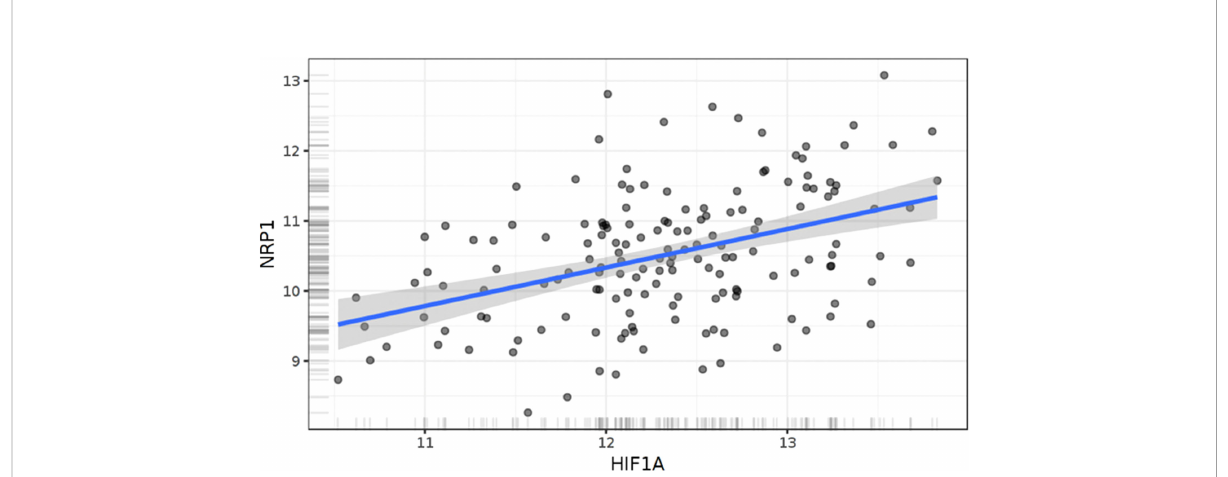
FIGURE 3 Correlation of Hif1 a and Nrp1 expression in human glioblastoma. Linear regression of NRP1 expression against HIF1 a . The results shown here are based upon data generated by the TCGA Research Network: https://www.cancer.gov/tcga." N=158 patients. R=0.42. p<0.0001, Pearson